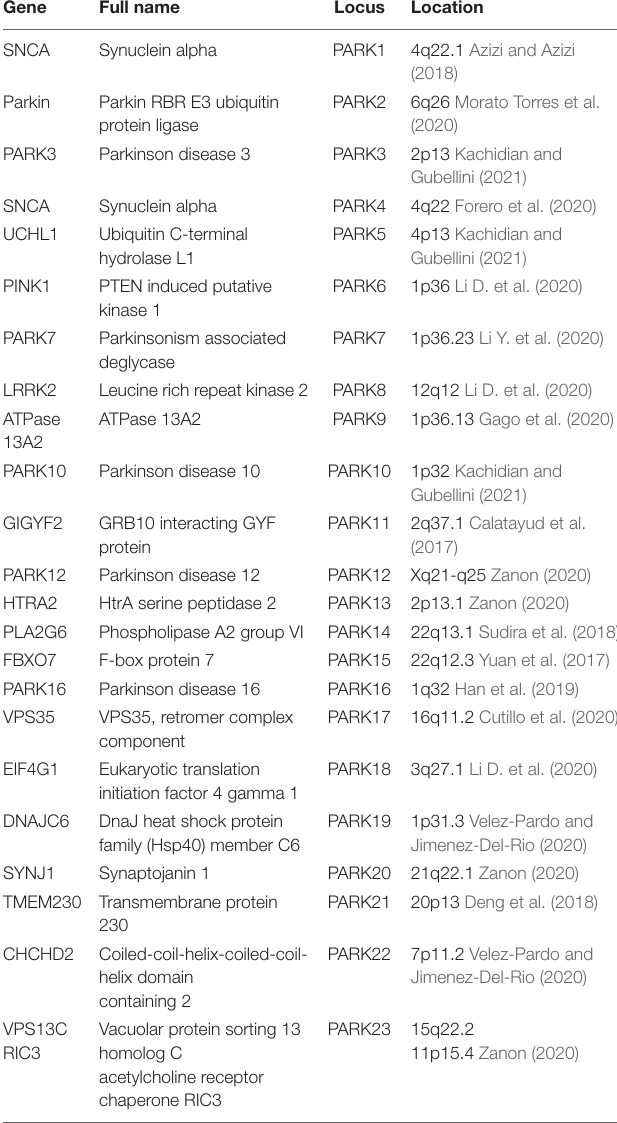
TABLE 1 | The genes associated with the pathogenesis of